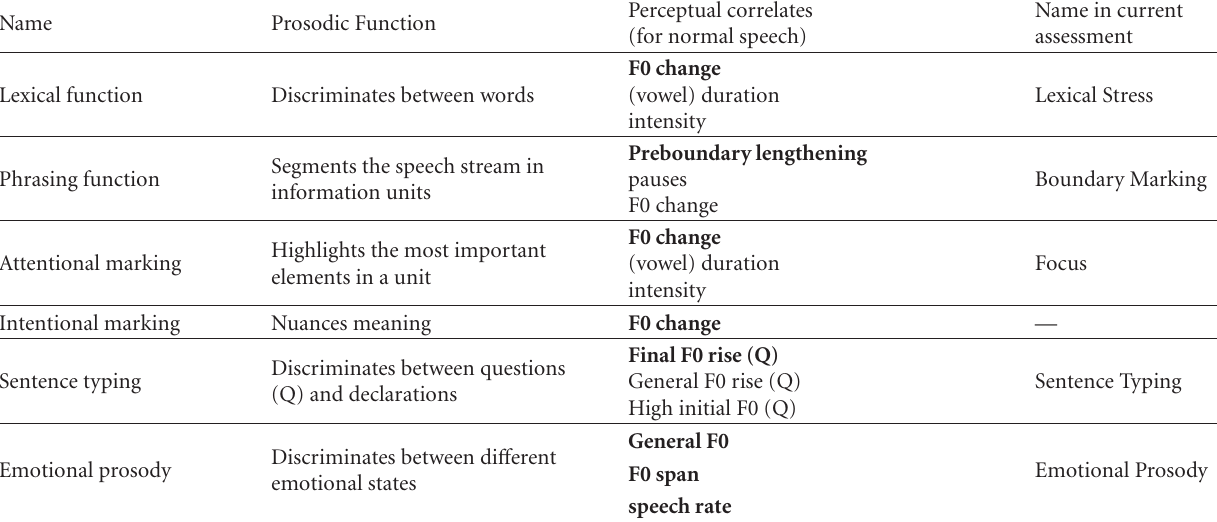
Table 1: Prosodic functions in Dutch: classification and perceptual correlates based upon Rietveld and van Heuven